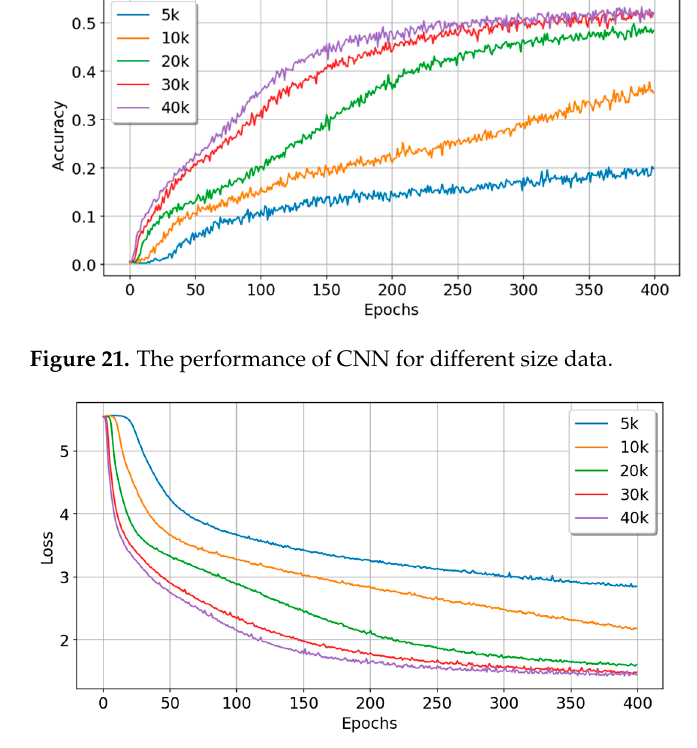
Table 5. Specific parameters and experimental results of the CNN model.